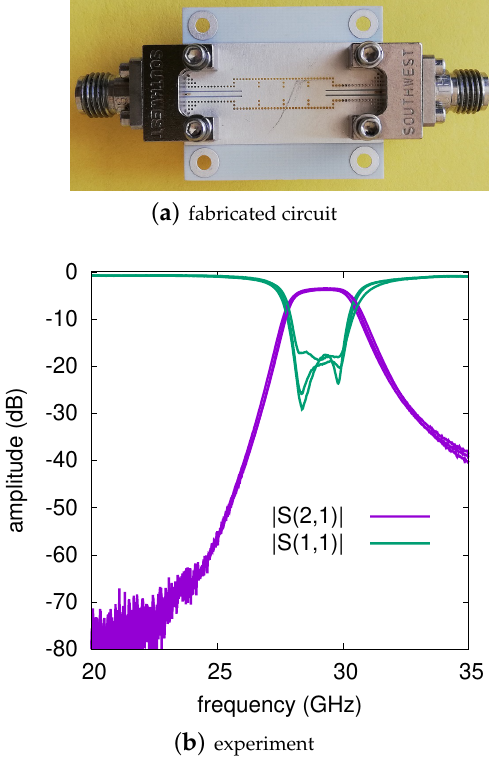
Figure 7. Image filter. 29.1 GHz image reject filter implemented in substrate integrated waveguide (SIW) technology: ( a ) layout; ( b ) experiment. The filter is realized on RO4350 material with h = 0.25mm, (cid:101) R = 3.48 and tan δ = 0.004. The measured insertion loss is of about 3.6dB including the feeding lines and the two coaxial-to-coplanar waveguide (CPW) end launchers. The return loss is around − 20dB